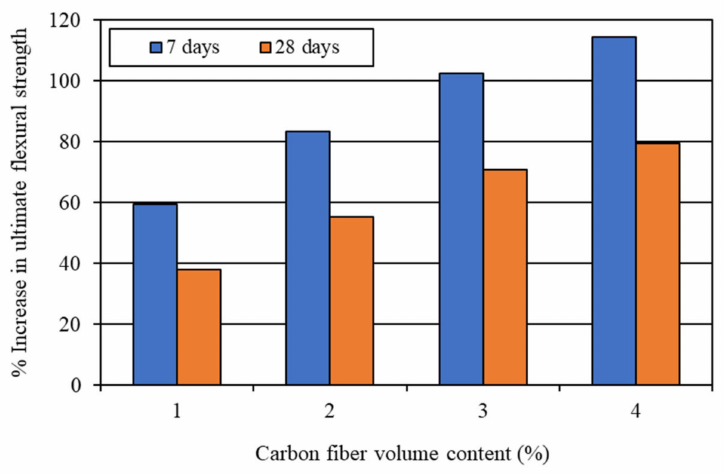
Figure 9. Increase in ultimate flexural strength due to the incorporation of carbon